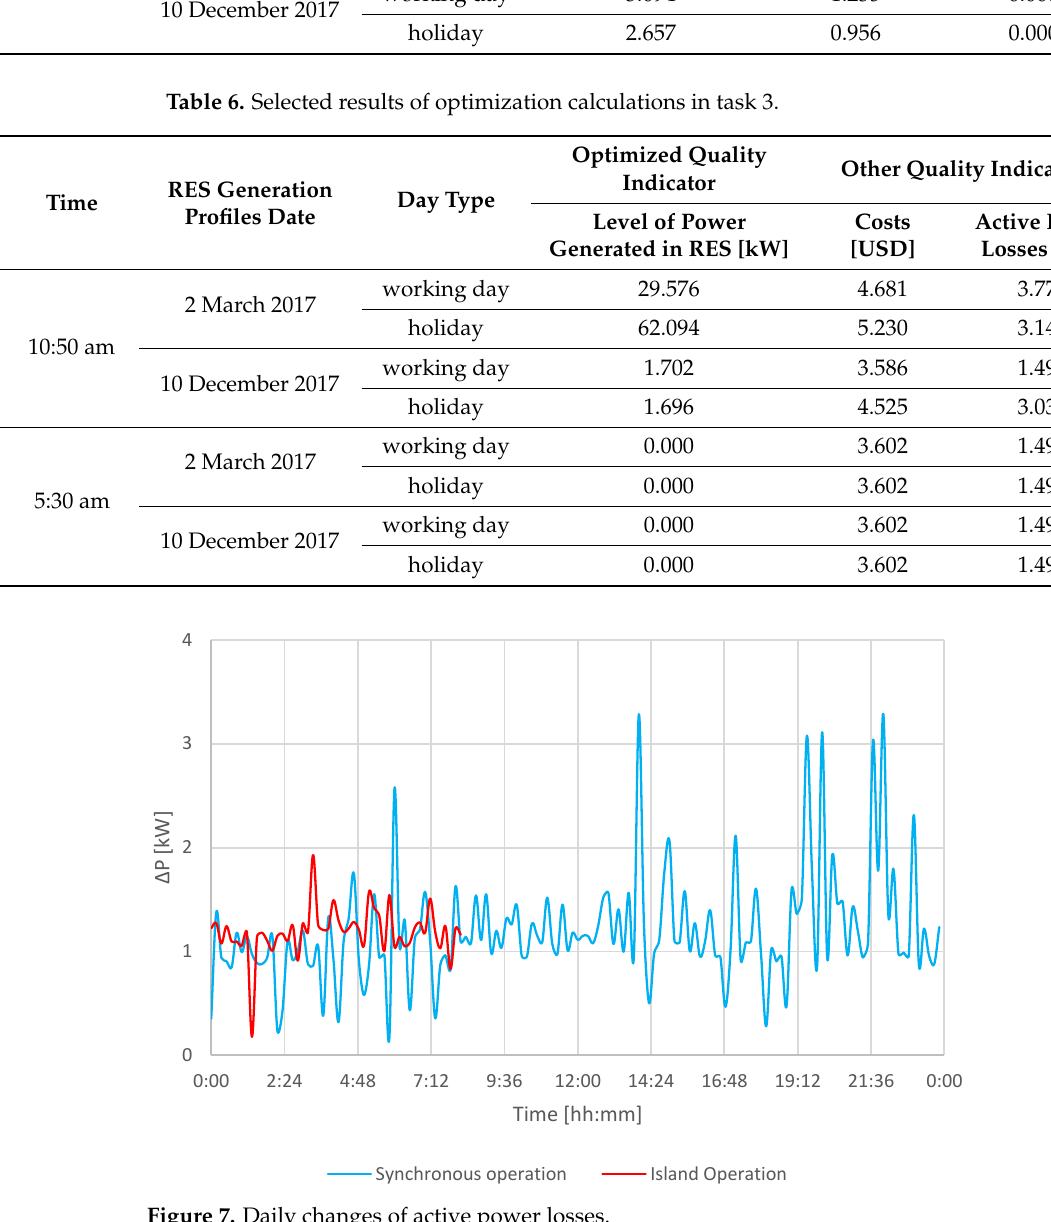
Figure 8. Daily changes of costs of operation of the hybrid test microgrid.